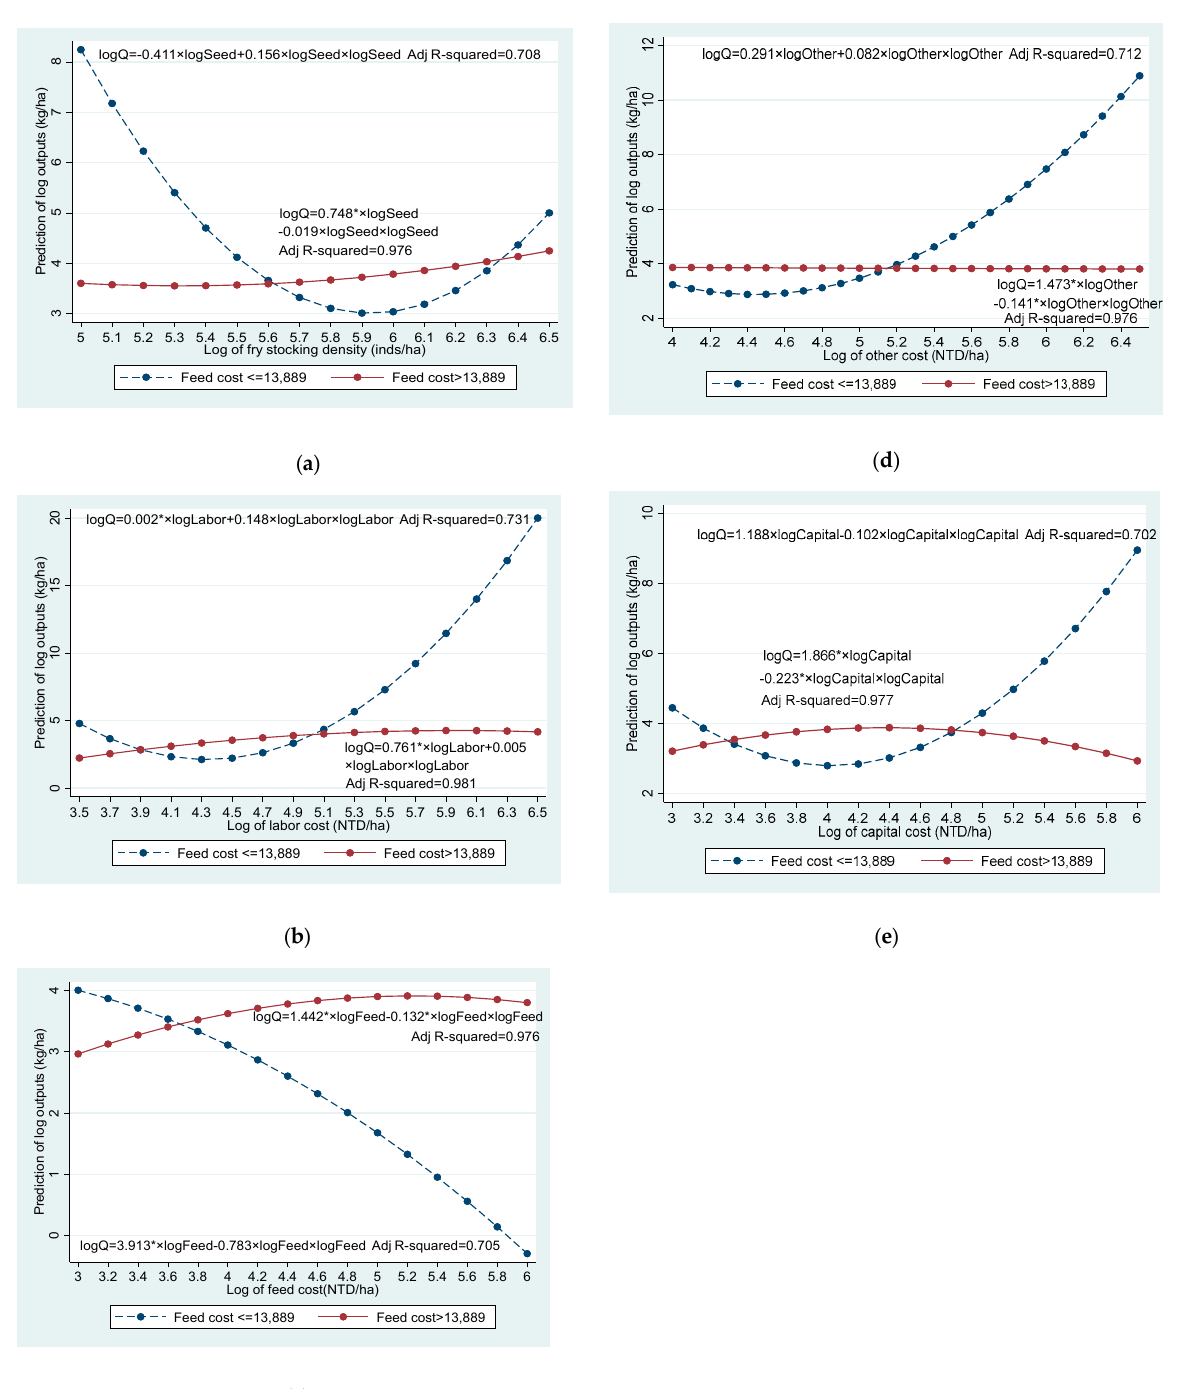
Figure 3. The threshold effect of feed cost on simulated hard calm productions with respect to control variables (Note: * significant at 5%; Source: Authors’ own calculations are based on the estimation of the threshold regression model). ( a ). Log of fry stocking density (inds/ha). ( b ). Log of labor cost (NTD/ha). ( c ). Log of feed cost (NTD/ha). ( d ). Log of other cost (NTD/ha). ( e ). Log of capital cost (NTD/ha).